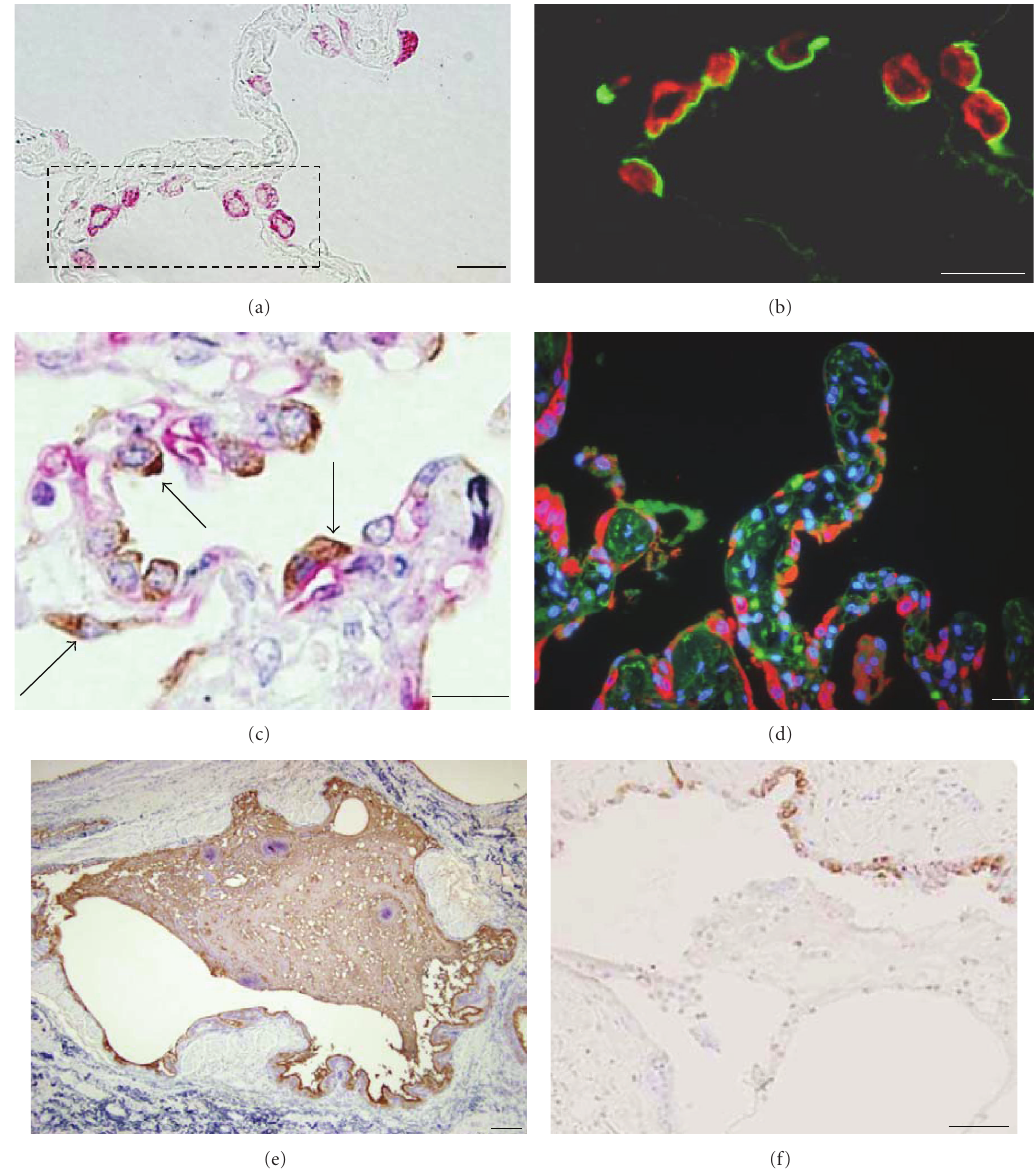
Figure 3: Immunohistochemical distribution of SP-D and KL-6/MUC1 in control and IPF lungs. ((a) and (b)) In control lungs, alveolar type II epithelial cells show cytoplasmic staining for SP-D (in red). In contrast, KL-6/MUC1 (in green, (b)) distributes extracellular surface facing alveolar space without cytoplasmic or basal-lateral side expression. The dotted square in (a) is the same section with (b) observed by fluorescence (scale bar = 10 μ m). (c) Double immunohistochemistry of SP-D (in brown) and CD34-positive alveolar capillary endothelial cells (in red) in IPF lung tissues. The alveolar type II epithelial cells with SP-D expression are always in close contact with alveolar capillaries (indicated by arrows). Counter staining by elastic-Goldner staining (scale bar = 10 μ m). (d) In IPF lung tissues, regenerated type II epithelial cells are increased with more intense expression of SP-D (in red) than control lungs. These increased type II epithelial are also in close contact with alveolar capillaries (in green). Nuclei are stained in blue (scale bar = 10 μ m). ((e), (f)) In honeycomb cysts in IPF lings, thick mucus with immunoreactive for KL-6/MUC1 (in brown, (e)) were accumulated in contrast to SP-D (in brown, (f)). Counterstained by elastica-Goldner staining (scale bars = 100 μ